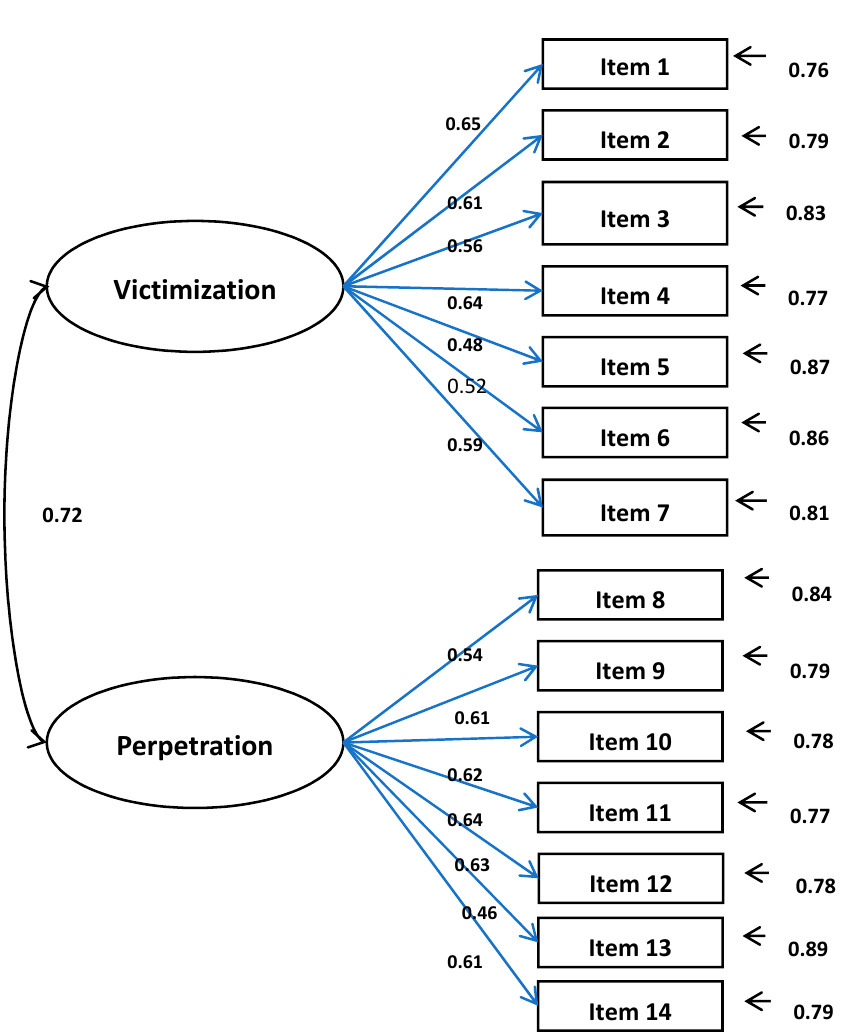
Figure 1. Confirmatory Factor Analyses of the European Bullying Intervention Project Questionnaire.